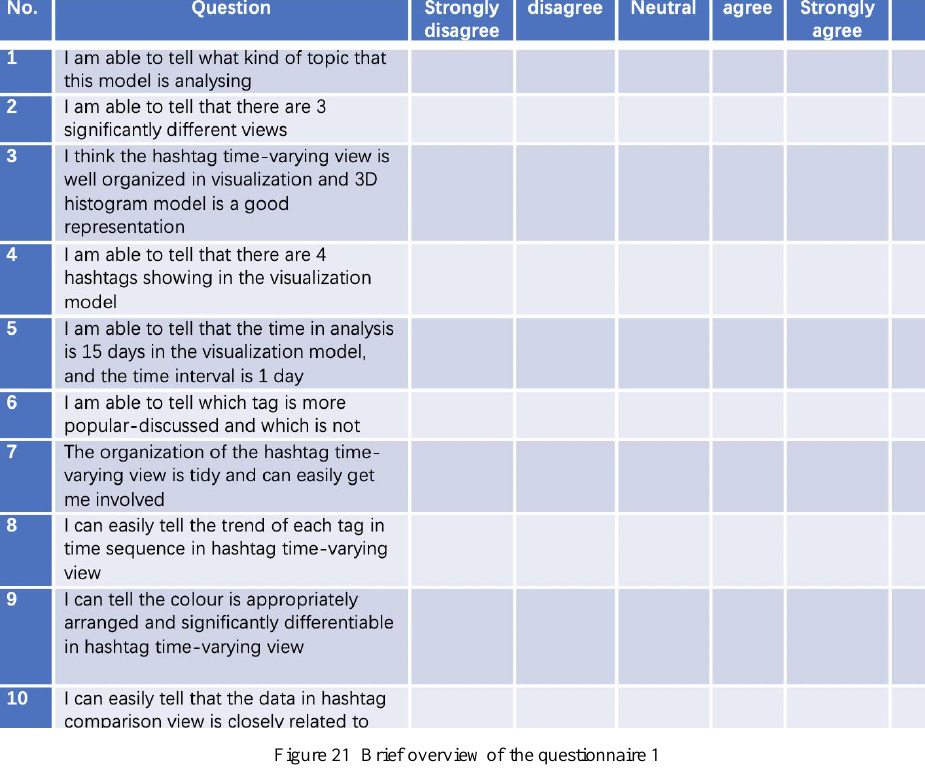
Figure 21 Brief overview of the questionnaire 1